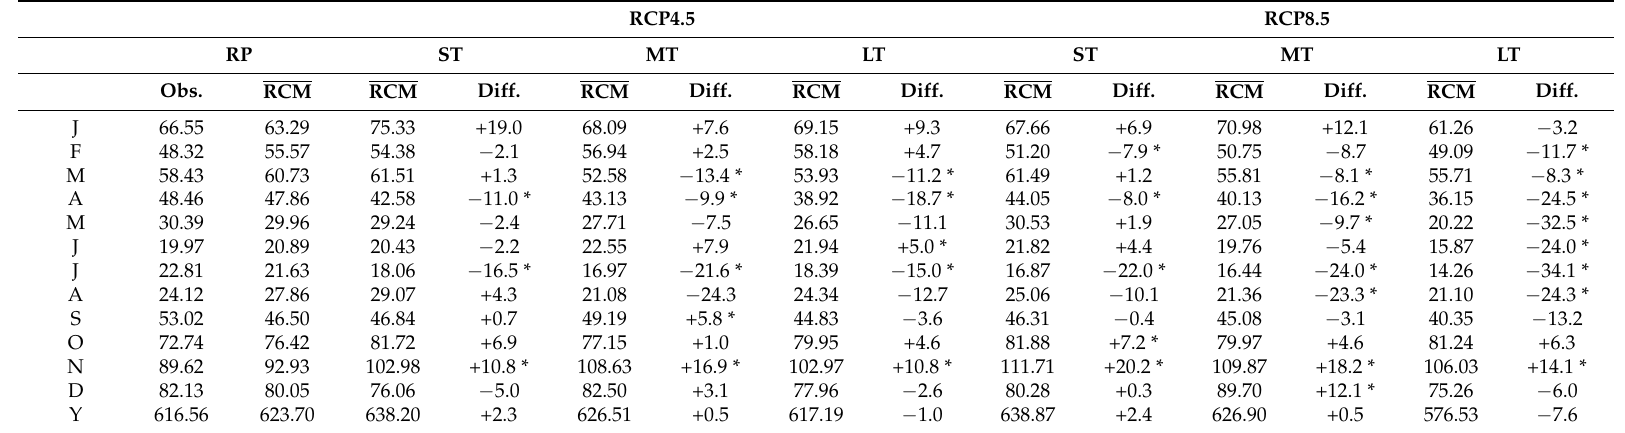
Table 4. Monthly and annual precipitation over the whole Salento area, for the reference period (RP, 1986 − 2005), at the short—(ST, 2016 − 2035), medium—(MT, 2046 − 2065) and long-term (LT, 2081 − 2100). Observed values (Obs., [mm]), RCM ensemble mean (RCM, [mm]) under the RCP4.5 and RCP8.5 scenarios and percentage differences (Diff., [%]) between the projections at ST, MT, LT and the RP ones; the symbol * means that the change is